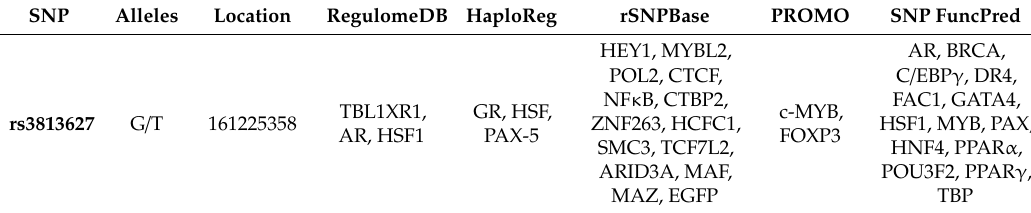
Figure 4. The position of rs3813627 is highlighted in light blue, showing that rs3813627 is in the promoter region of APOA2 and overlaps several DNase hypersensitivity clusters and TBL1XR1 transcription factor determined by experimental procedures (ENCODE project). The red bar shows the position of the SNP on the chromosome. The blue color shows the position of the genes. The black and gray color show the binding sites of the transcription factors throughout the sequence. Table 6. Transcription factors and motifs overlapping the rs3813627 APOA2 Table 7. General information about SNPs in APOA1 and APOA2 on lipid traits.